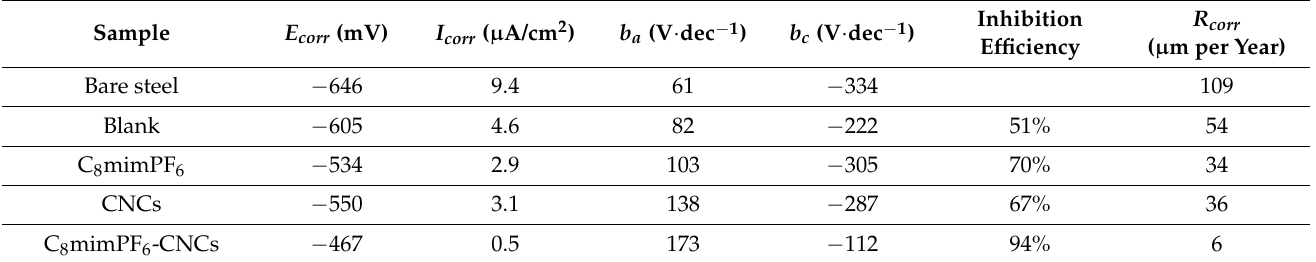
Figure 7. Tafel plots of coated and uncoated samples after 96 h of immersion. Table 1. Tafel parameters and calculated corrosion variables of the coated and uncoated samples after 96 h of